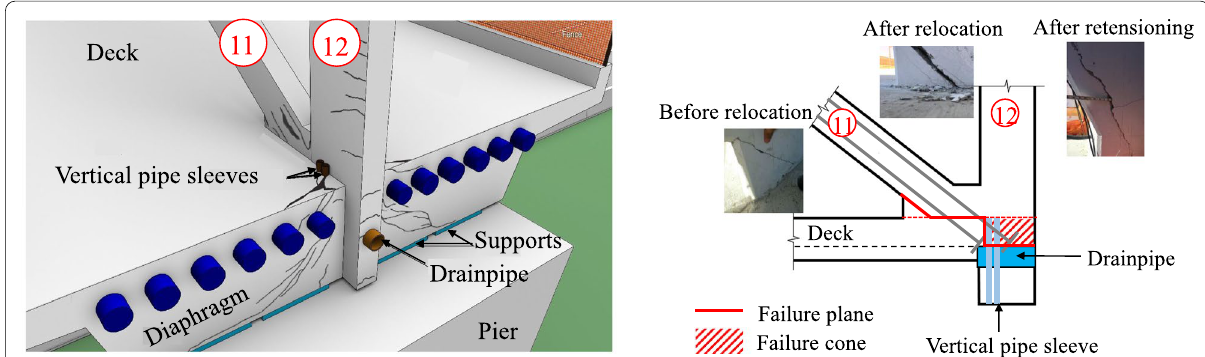
Fig. 8 Development of cracks in the deck and the diaphragm after de-tensioning of member 11: a the crack pattern at nodal region 11–12 [13]; and b the evolution of cracks and the failure mechanism of nodal region 11–12 [12,